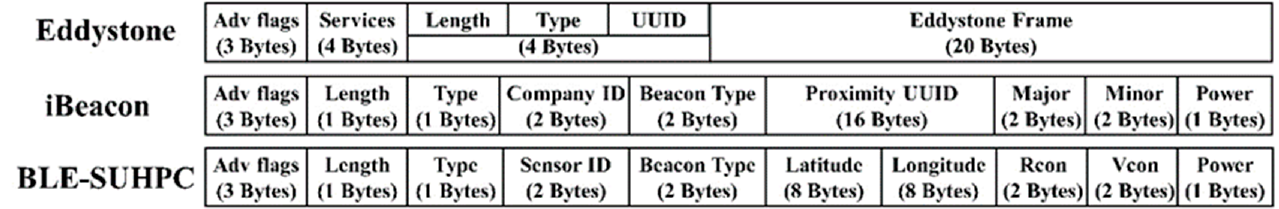
Figure 4. Packets used in different protocols for BLE communication.